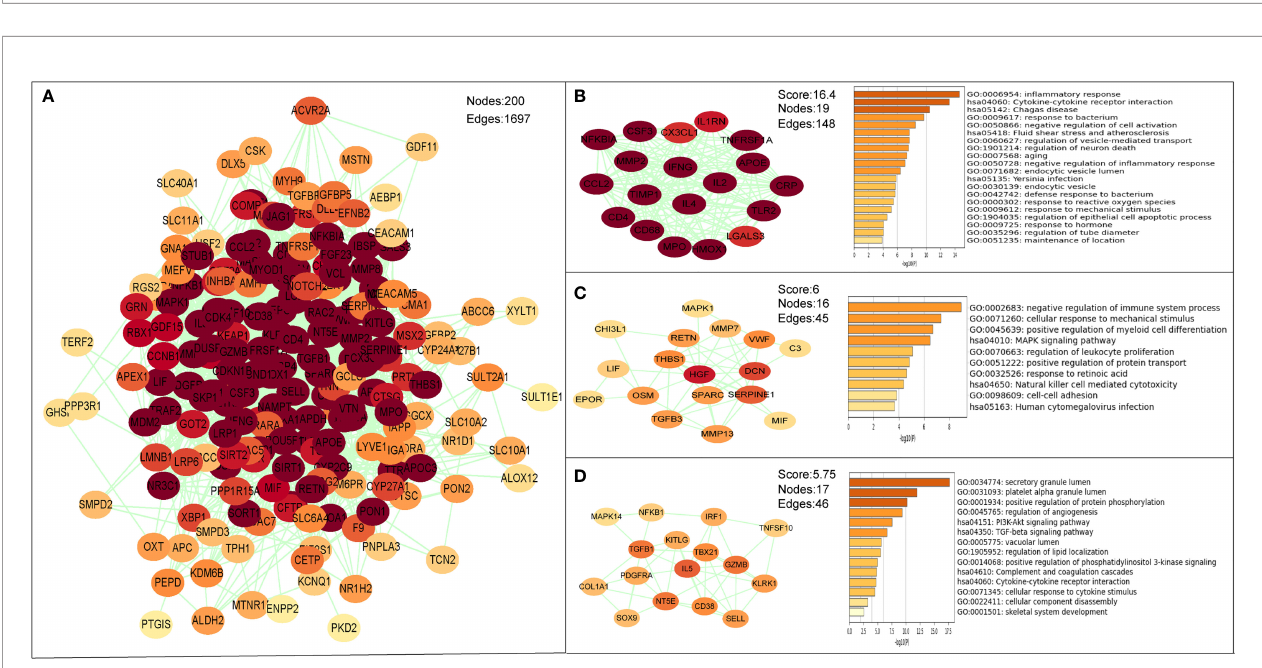
FIGURE 6 | Analysis of common targets between osteoporosis and atherosclerosis from three public databases. (A – C) Venn diagram of common targets between atherosclerosis and osteoporosis. (D) KEGG enrichment analysis of the common targets. (E) GO enrichment analysis of the common